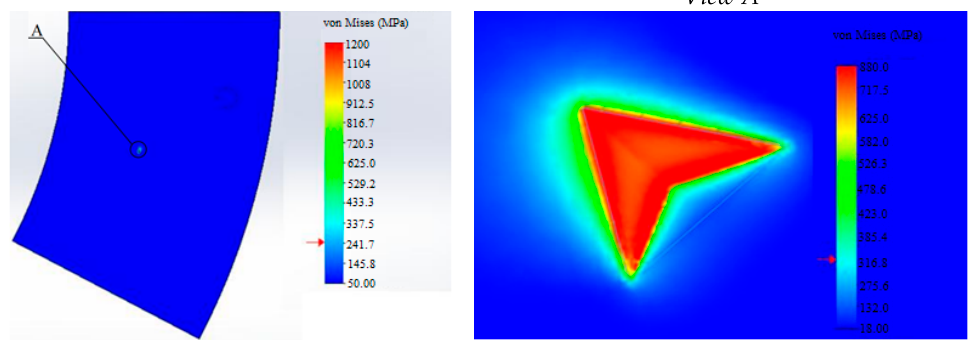
Figure 13. The stress field in the part of the thrust bearing disc and defect No. 2.